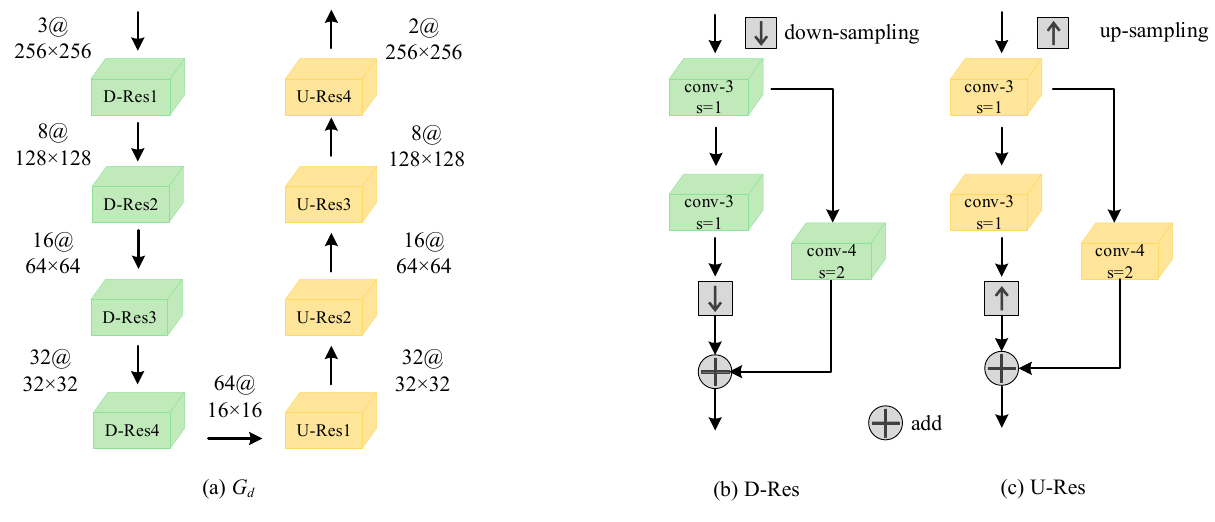
Figure 5. The proposed network of G d.